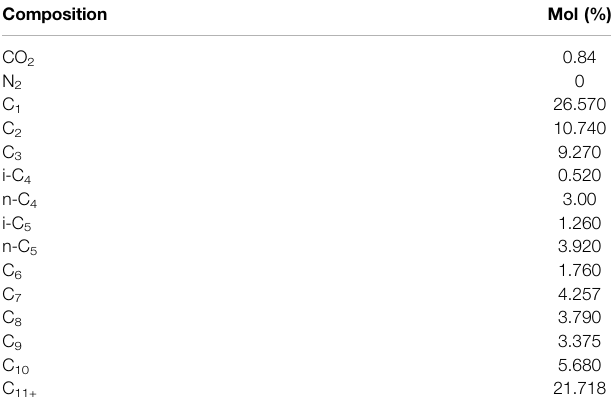
TABLE 2 | Composition of crude oil samples in the simulation.